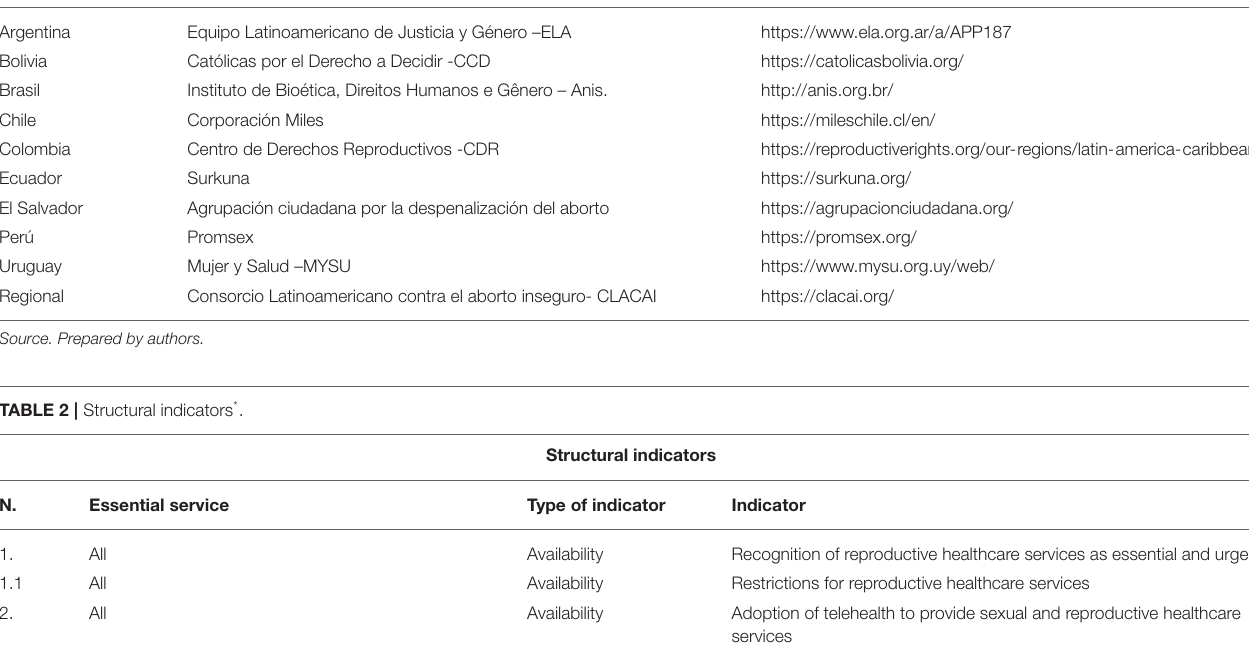
TABLE 1 | Organizations involved in the study.